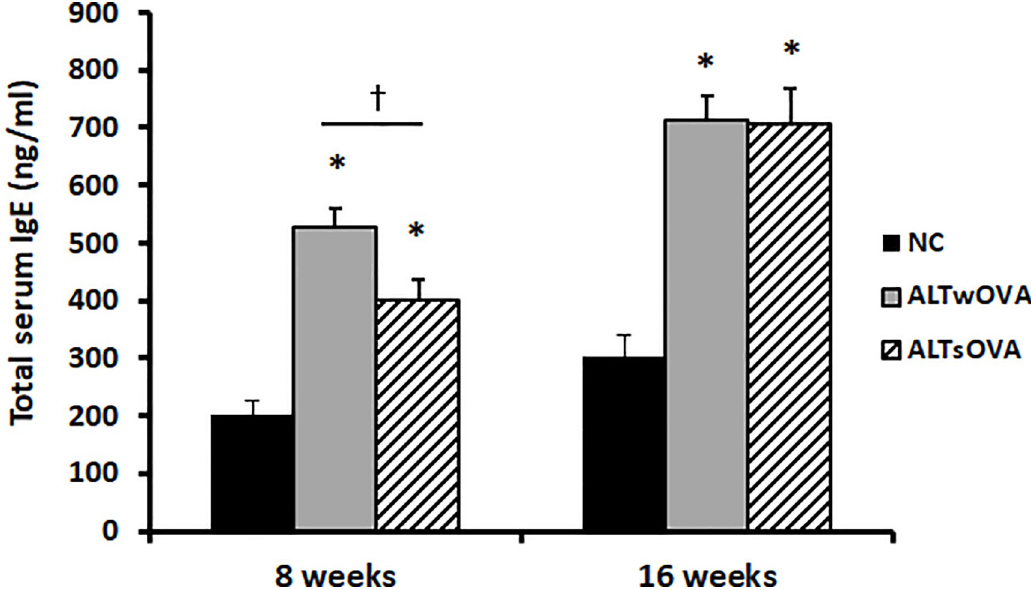
Fig 2. Total serum IgE level at 8 and 16 weeks with repetitive instillation of Alternaria . IgE level was significantly increased both allergic and non-allergic mouse model (n = 7 mice per group). NC: negative control, ALTwOVA: Alternaria instillation with ovalbumin (OVA) presensitization, ALTsOVA; Alternaria instillation without ovalbumin (OVA) presensitization. � p < 0.05 vs NC group.